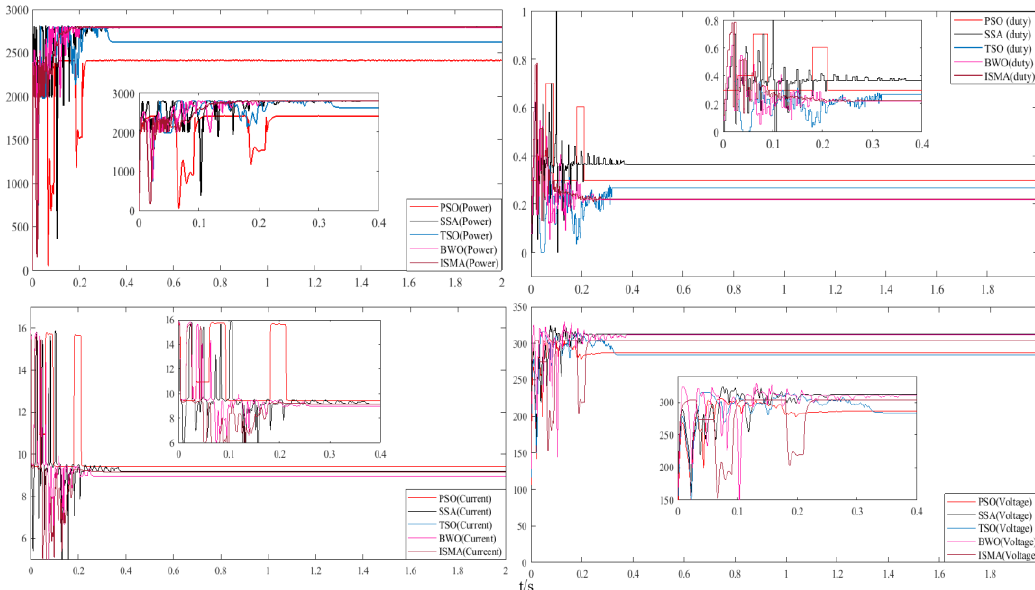
Figure 9. Output curves of five different algorithms under PSC2 conditions.